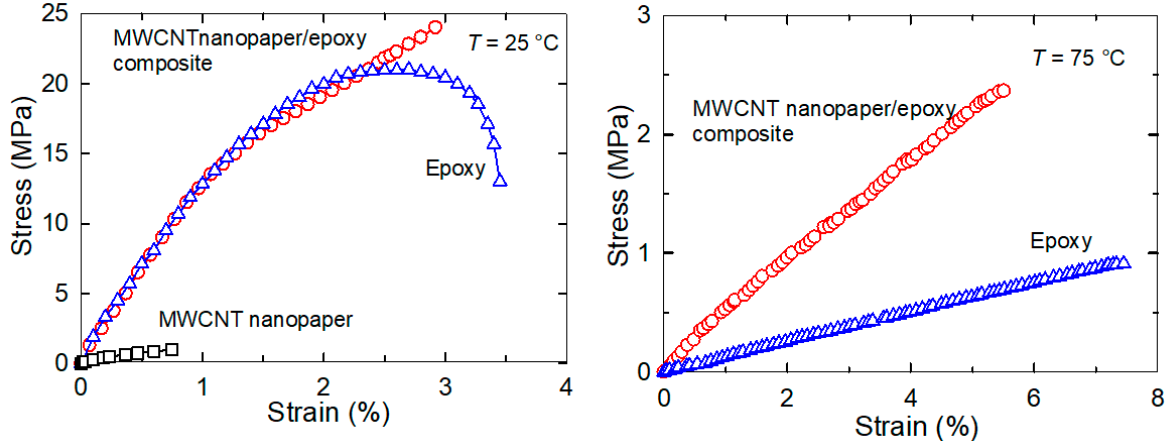
Figure 2. Left panel: tensile tests of the MWCNT nanopaper (squares), the glassy MWCNT nanopaper/epoxy composite (circles) and the glassy cured epoxy (triangles) at the elongation rate of 1 mm/min at the temperature 25 °C [18]. Right panel: tensile tests of the rubbery MWCNT nanopaper/epoxy composite (circles) and the rubbery epoxy (triangles) at the elongation rate of 1 mm/min at the temperature of 75 °C.